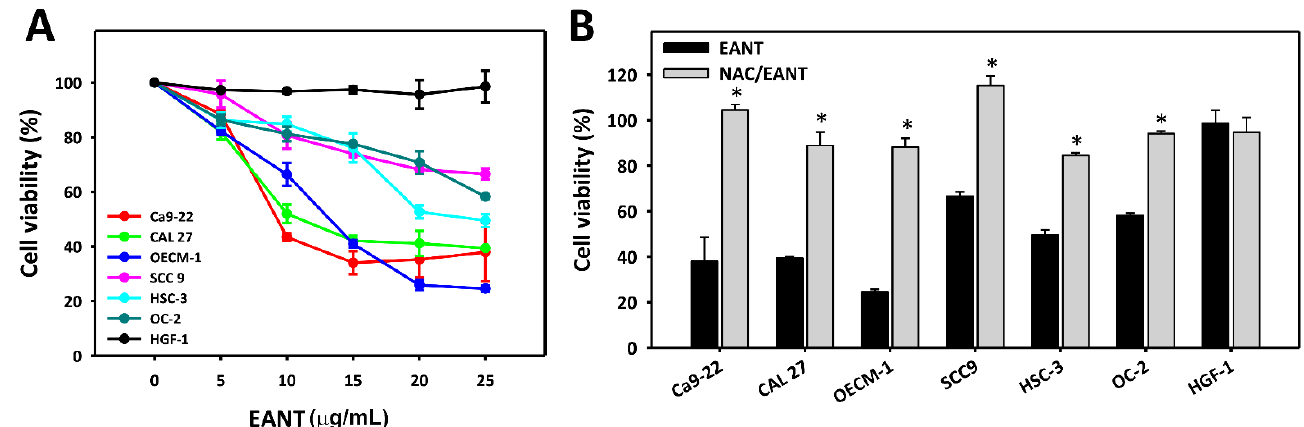
Figure 1. Cell viability. ( A ) Cell viability for several oral cancer cell lines and normal oral (HGF-1) cell lines in EANT treatments for 24 h MTS assay. ( B ) NAC (2 mM) pretreatment outcome of EANT treatments (0 and 25 μg/mL) for 24 h MTS assay. The cell viability of untreated controls for each oral cancer cell line was adjusted to 100%, which is not shown here. Data (means ± SD, n = 3) showing * differ in significance for paired comparisons ( p < 0.05).